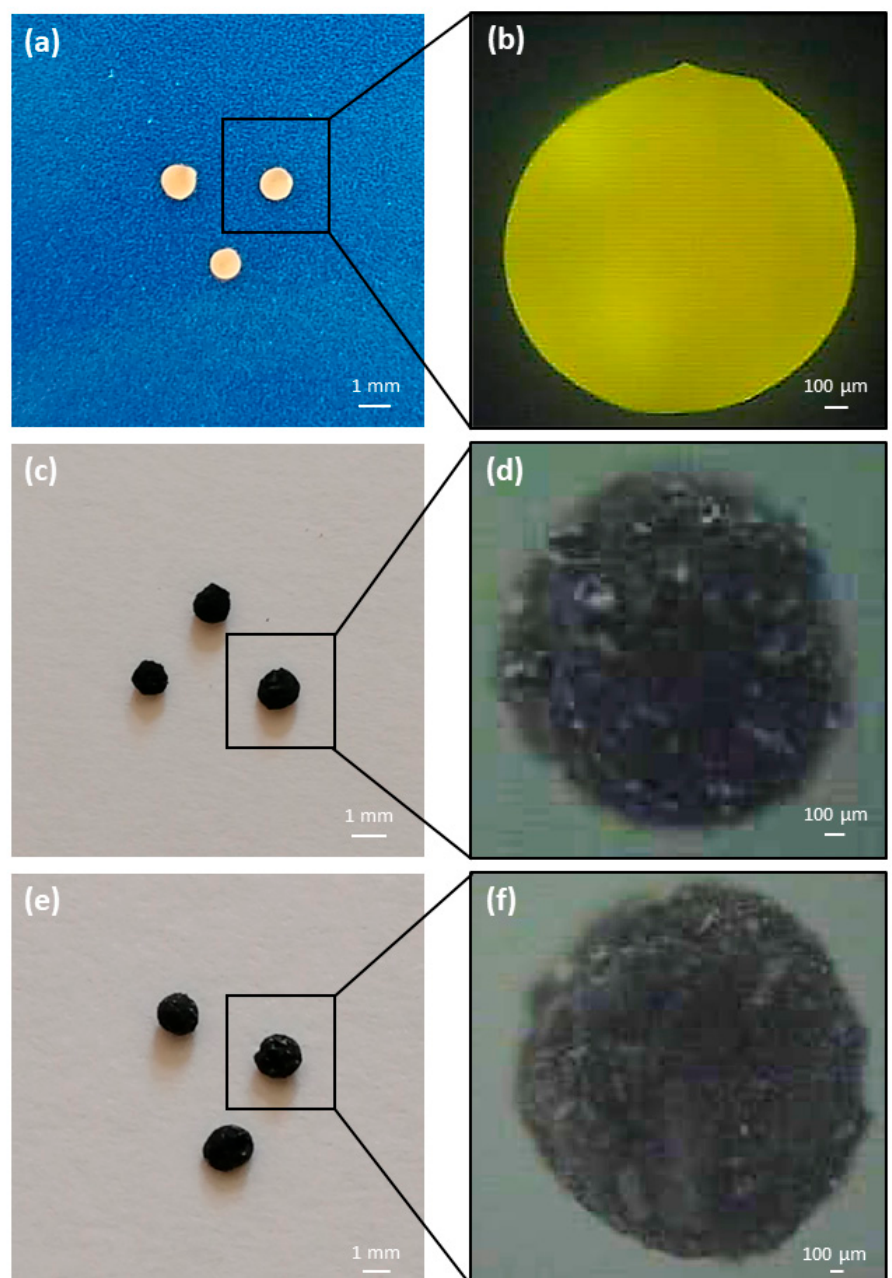
Figure 1. Representative photographs ( a , c , e ) and micrographs ( b , d , f ) of the alginate-based